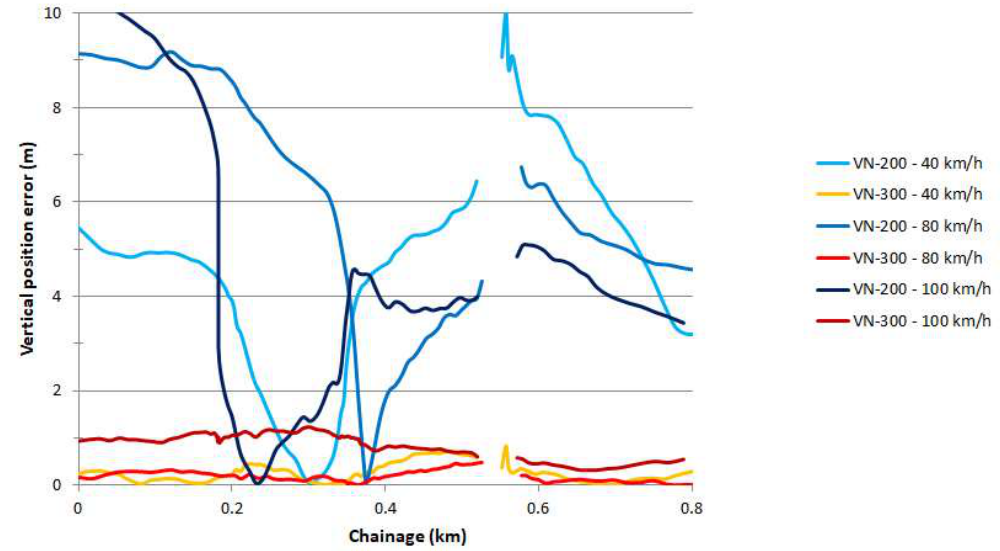
Figure 9. Variability in one-dimensional (1D) position errors recorded by the VN-200 and VN-300 devices as a function of the route length when travelling at speeds of 40 km/h, 80 km/h and 100 km/h along section no. 3.